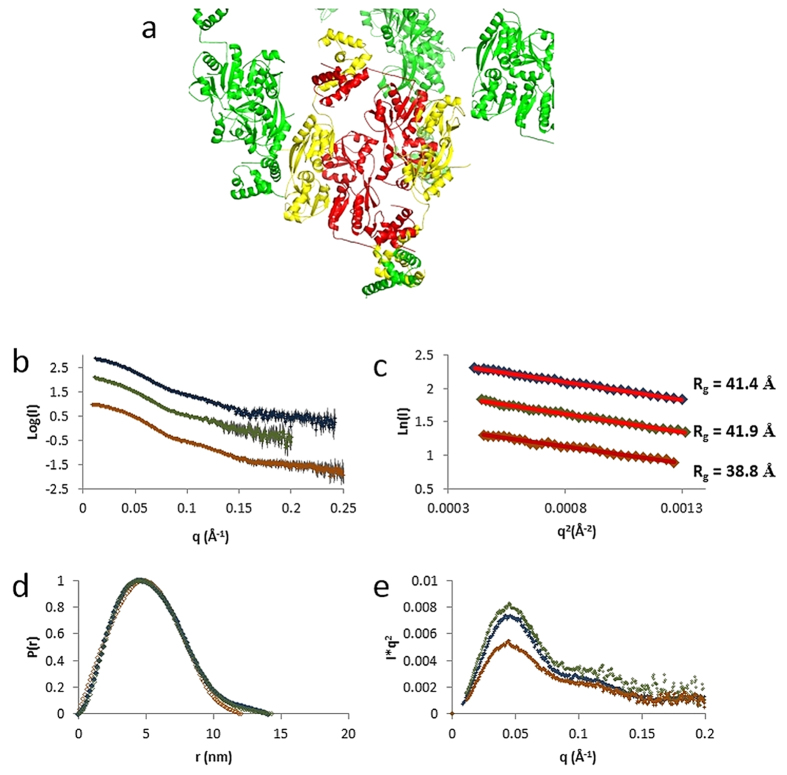
Crystal packing and SAXS analysis of the solution conformations of
apo-DntR, H169T-DntR and holo-DntR.(a) An examination of the packing of the crystal form obtained for
both apo- and H169T-DntR shows that this constrains apo- and
H169T-DntR to adopt the same compact tetrameric configuration. Here an
apo-DntR tetramer is shown in red and yellow and symmetry related
DntR monomers are shown in green. For clarity not all symmetry-relate
monomers in close contact with the tetramer are shown. (b)
Experimental solution scattering curves (open squares) and the resulting
fitted model (solid line) for apo-DntR (orange), H169T-DntR (green)
and holo-DntR (blue). (c) Guinier plot regions the fits of
which (solid lines, colour scheme as in (b)) yield the radii of
gyration (Rg) shown. (d) The pair distribution functions
P(r) indicating Dmax for apo-DntR
(118.2 Å), H169T-DntR
(135 Å) holo-DntR
(142 Å). Colour scheme as in (b). (e)
Kratky plots (colour scheme as in (b)) for apo-, H169T- and
holo-DntR.